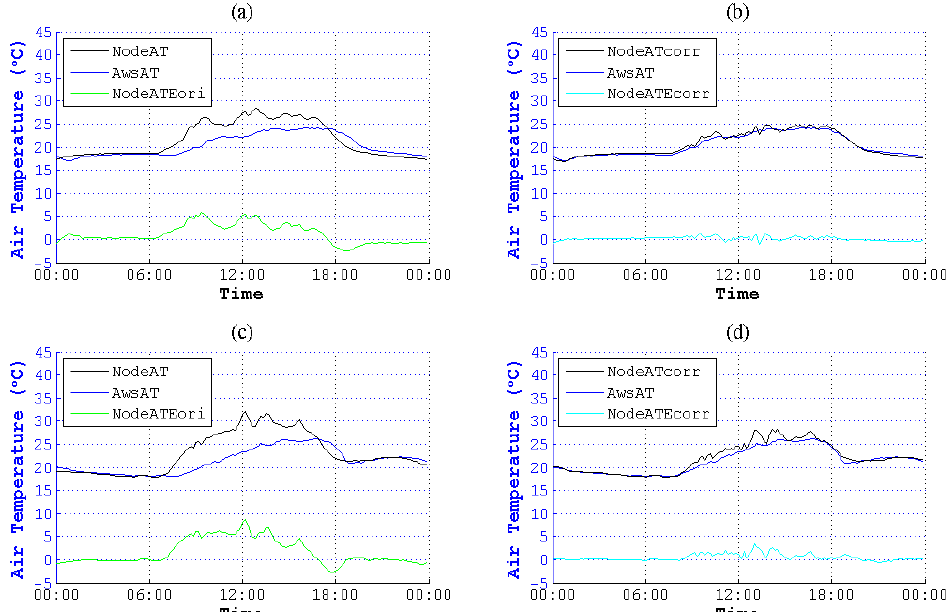
Figure 15. Contrast of NodeAT and NodeATcorr on 2 October 2014 and 19 October 2014. ( a ) Original data on 2 October 2014; ( b ) corrected data on 2 October 2014; ( c ) original data on 19 October 2014; ( d ) corrected data on 19 October 2014.